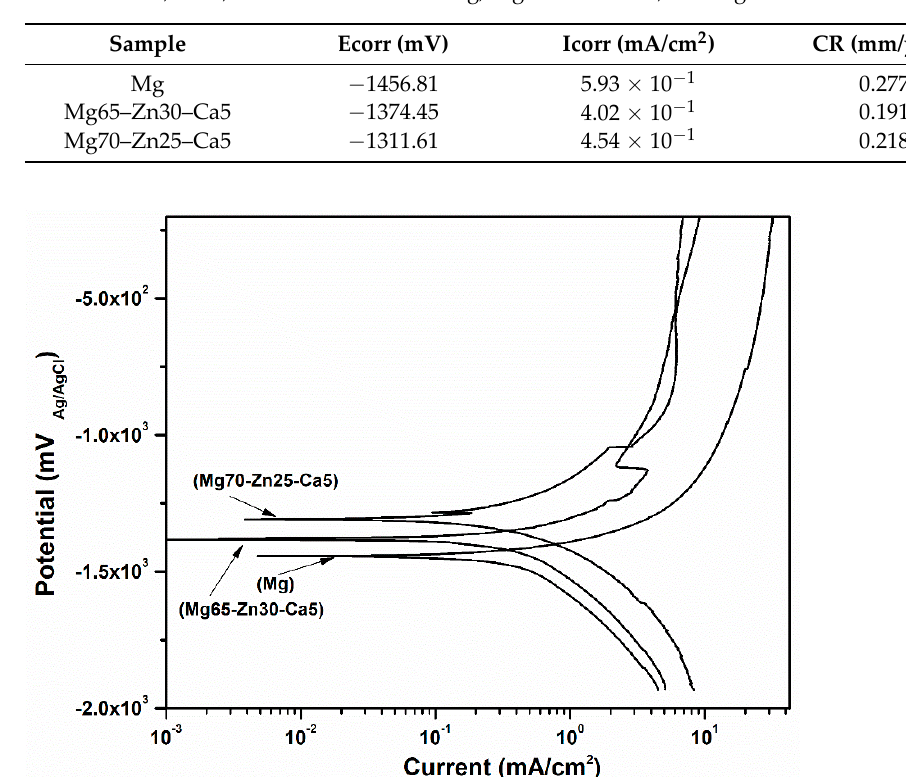
Figure 10. Potentiodynamic polarization curves of Mg, Mg65–Zn30–Ca5, and Mg70–Zn25–Ca5.